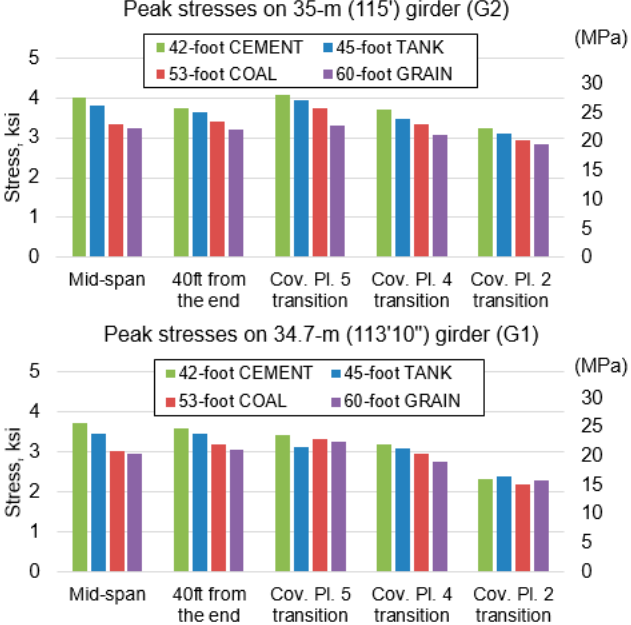
Figure 21. Typical peak stress calculated from measured strains—comparison for south girder (top) and north girder (bottom).